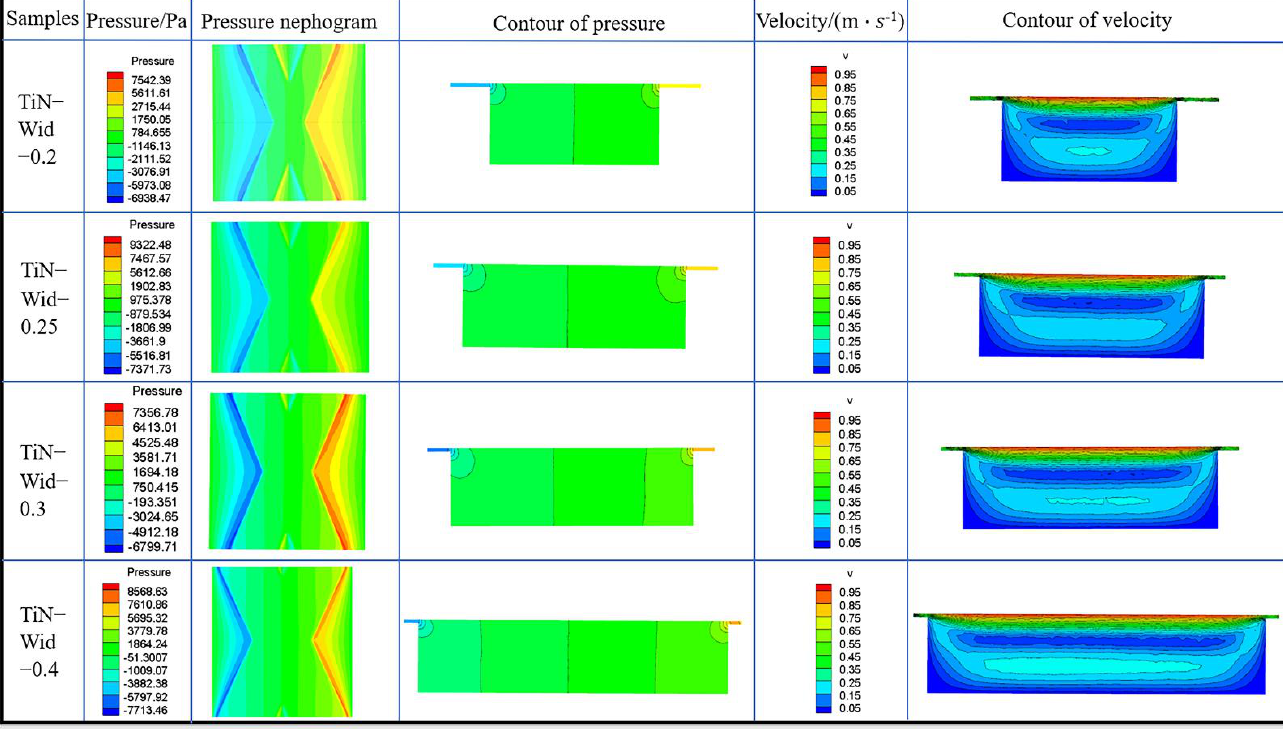
Figure 6. Simulation results with different groove widths.